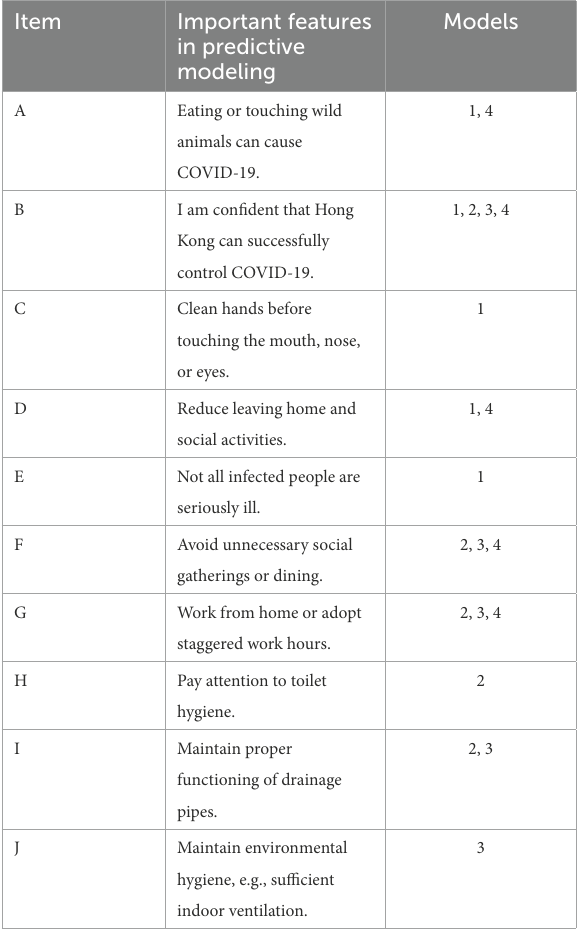
TABLE 3 Important features of the four